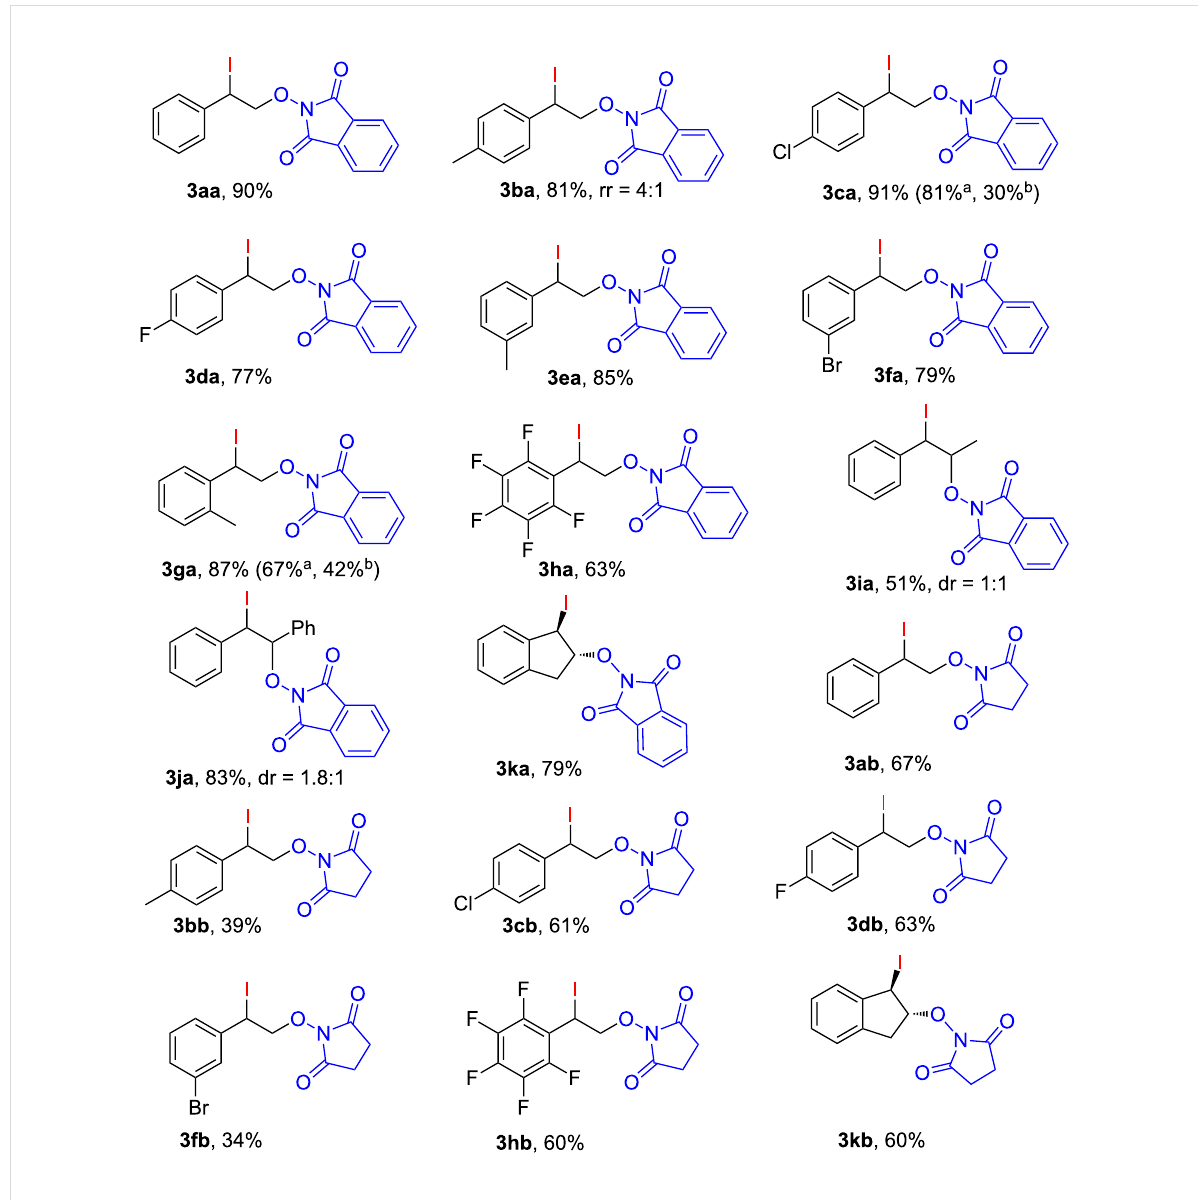
Figure 1: Scope of the iodo-oxyimidation of vinylarenes with I 2 /PhI(OAc) 2 system. Reaction conditions: vinylarene 1a – k (0.5 mmol), N -hydroxyimide 2a , b (0.5 mmol), I 2 (0.25 mmol), PhI(OAc) 2 (0.3 mmol), DCM (3.0 mL), 20–25 °C, 10 min, under air. rr = regioisomers ratio. a IBX (0.5 mmol) was used instead of PhI(OAc) 2 , reaction time: 24 h. b DMP (0.15 mmol) was used instead of PhI(OAc) 2 , reaction time 30 min.